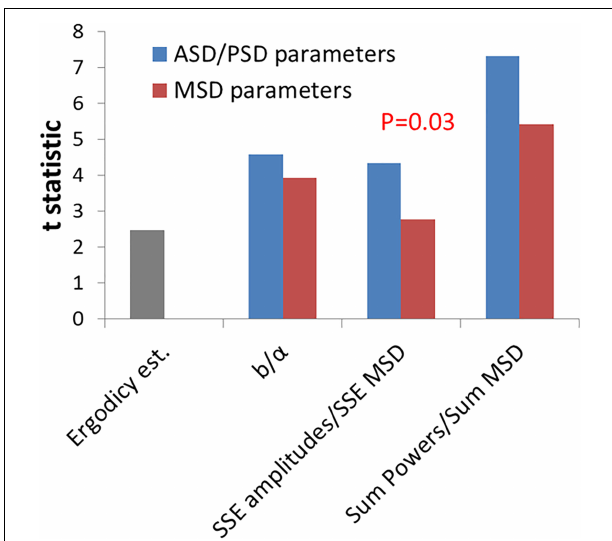
FIGURE 5 | Comparing the discrimination power of power spectral density (PSD)/amplitude spectral density (ASD) vs. mean square displacement (MSD) analyses for intracellular mechanical work. T-statistics values for the difference between cells before ATP depletion and the same cells after ATP depletion according to the two groups of parameters: ASD/PSD analysis based parameters in compare to MSD analysis based parameters. Corresponding parameters from the two groups are compared: the b parameter vs. α , sum of squared errors (SSE) of amplitudes vs. SSE of MSD’s, and “Sum of powers” vs. Sum of MSD’s. The t-statistics value for the ergodic test (described in “Results” section) is also presented. The P -values for the difference in t-statistics values between ASD/PSD parameters and the corresponding MSD parameters was calculated according to t -test for paired two samples and was found to be